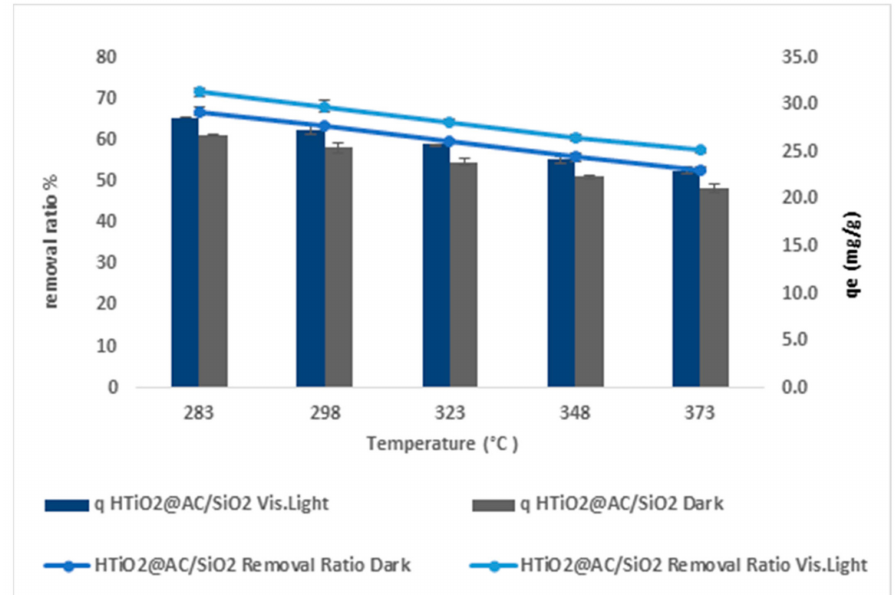
Figure 10. Temperature effect on HTiO 2 @AC/SiO 2